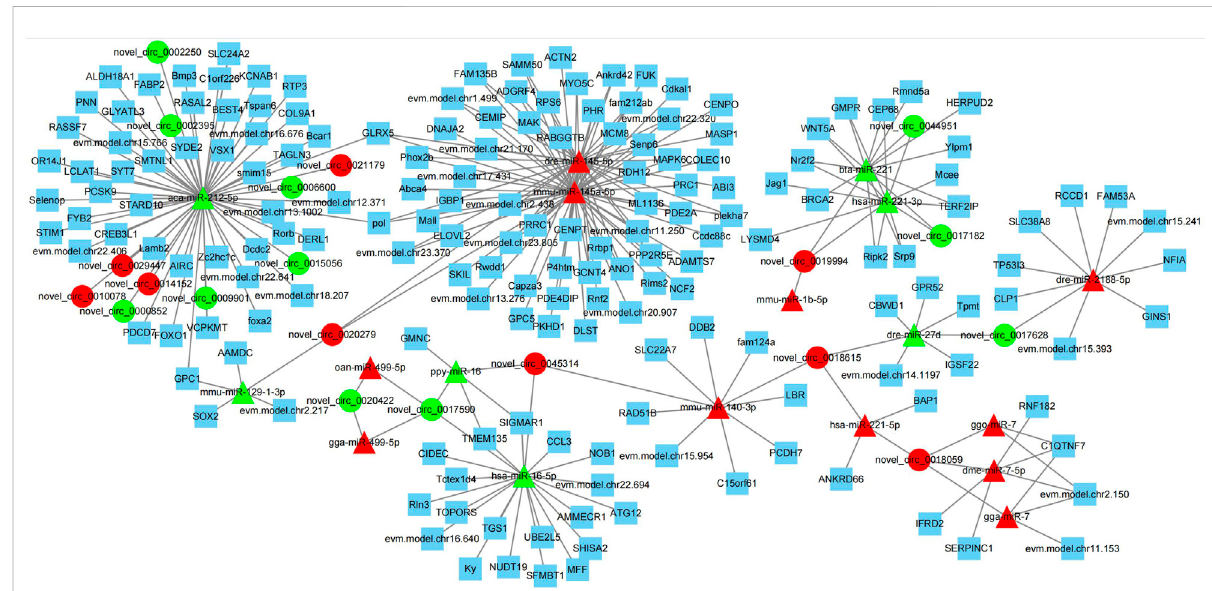
FIGURE 9 Interaction diagram of differential circRNA-miRNA-mRNA network. Triangle nodes represent the targeted miRNAs, circular nodes show circRNAs, and squares nodes show mRNA. Red color represent up-regulated, and green color indicate down-regulated.